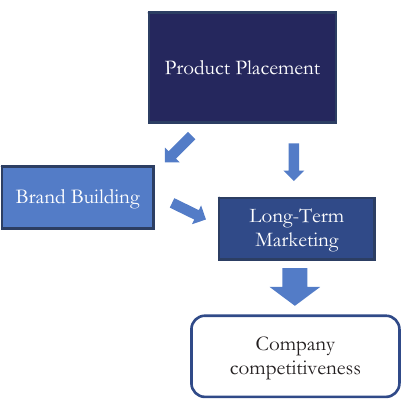
Fig. 3 - Product Placement influence on company competitiveness. Source: